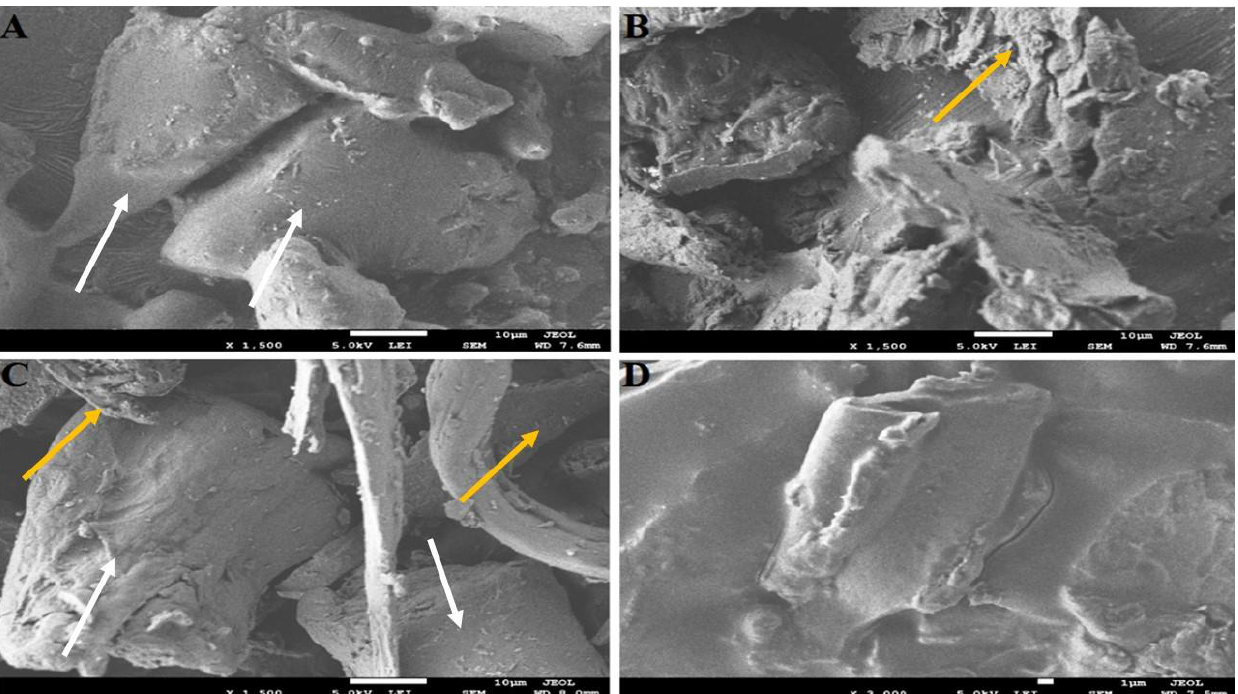
Figure 2. PXRD characterizations of Ginkgo biloba ginkgo extract (GK), alginate (A), their dry physi- cal mixture (PM), and nanocomplex gel (NG).